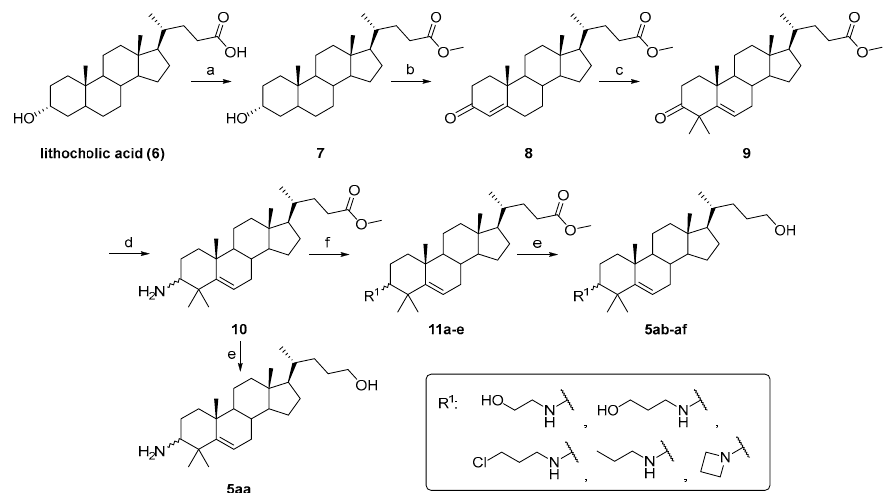
Scheme 1. Synthesis of compounds 5aa-af . Reagents and conditions: (a) TsOH . H 2 O, MeOH, reflux, 100%. (b) IBX, TFA, DMSO, 50 °C, 53%. (c) CH 3 I, KO t Bu, t BuOH, r.t.; then, TsOH . H 2 O, MeOH, reflux, 50%. (d) NH 4 OAc, NaBH 3 CN, NH 3. H 2 O, EtOH, reflux, 75%. (e) LiAlH 4 , THF, r.t., 52–90%. (f) K 2 CO 3 , DMF, r.t. or 80 °C, 47–86%.